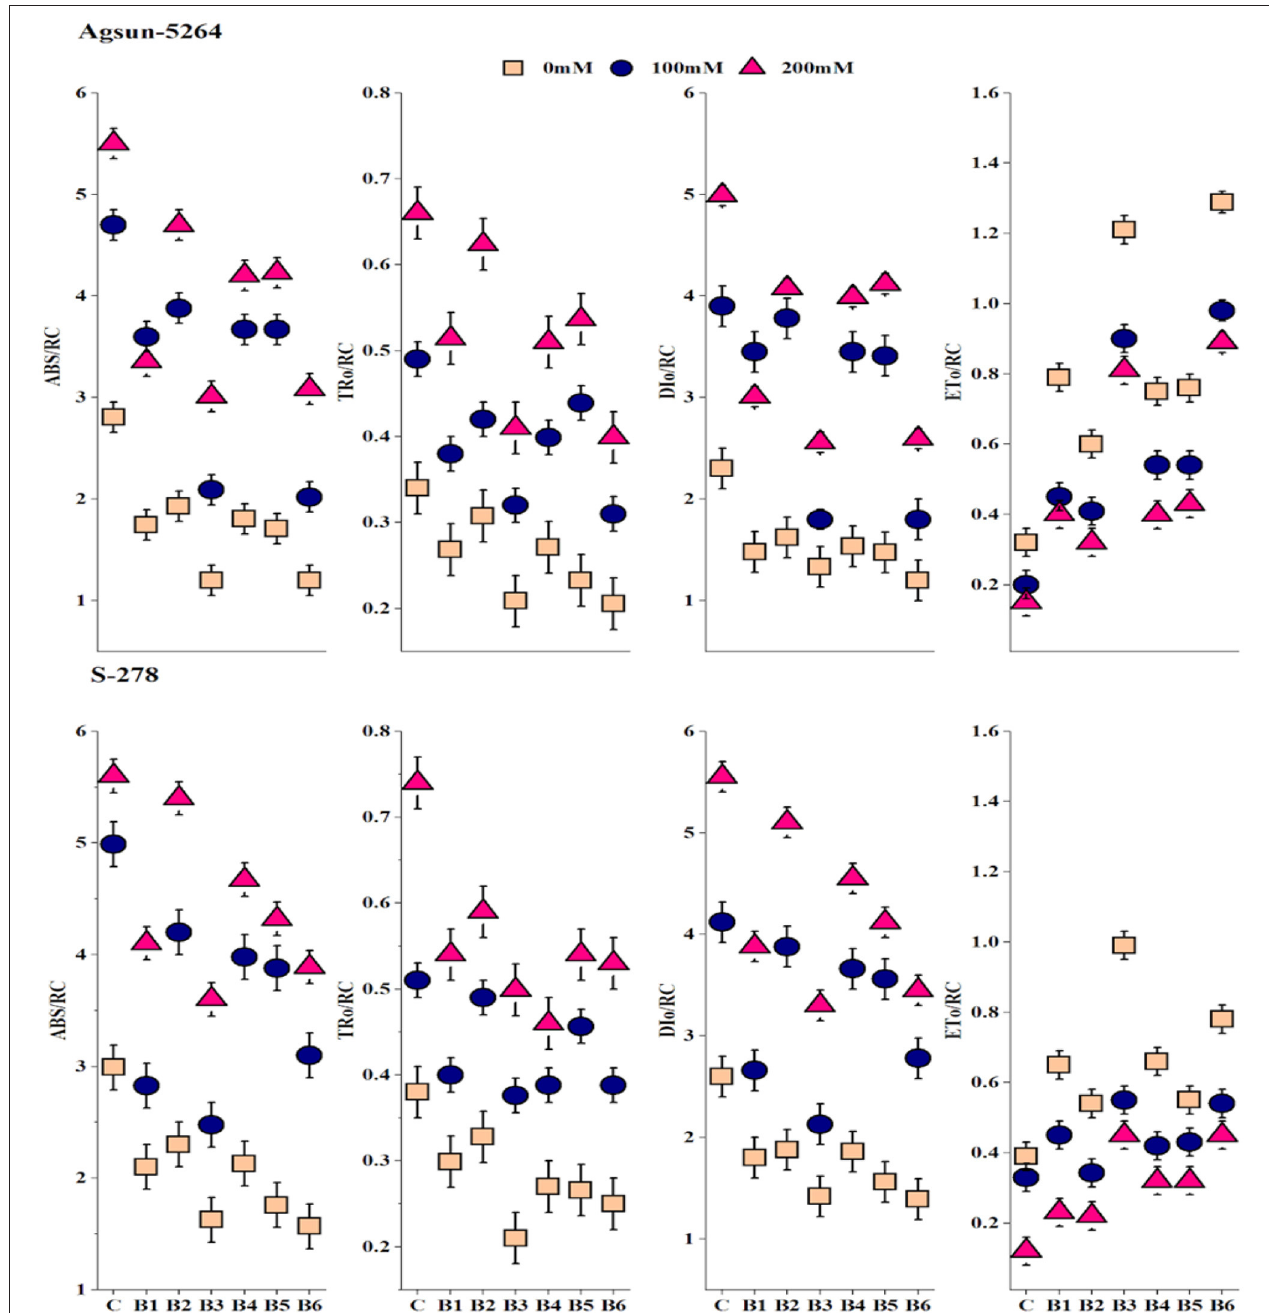
FIGURE 4 | Effect of halophilic microbial strains on changes in specific energy fluxes per reaction center including Absorption per reaction center (ABS/RC), Trapping per reaction center (TR O /RC), Electron transport per reaction center (ET O /RC) and Dissipation per reaction center (DI O /RC) of sunflower cultivars during salinity stress. Vertical line on the bar represents mean standard error (S.E). Similar alphabet shows non-significant difference at p ≤ 0.05 ( Bonferroni post-hoc test ) between